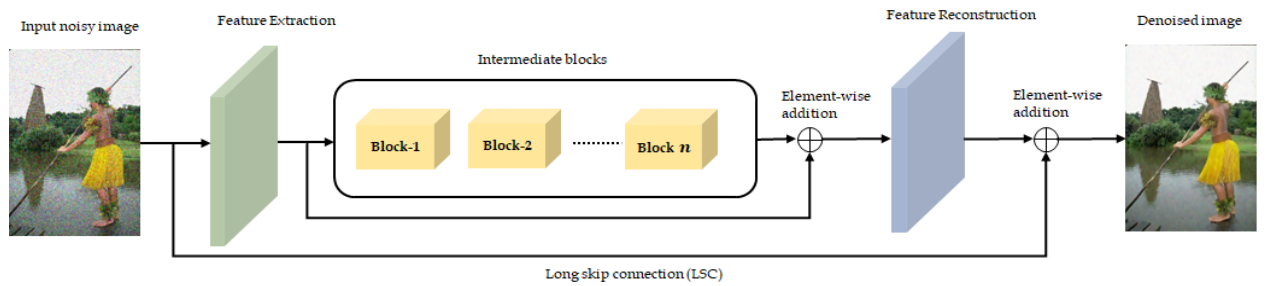
consists of the more prolonged feature extraction phase with cascaded modules, which begin right after the initial feature collection and end with the final residual